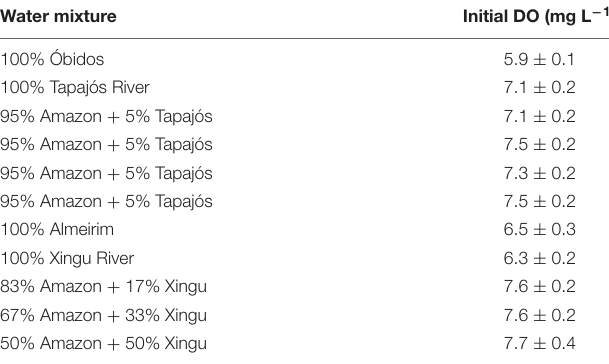
TABLE 2 | Average ( ± 1 SD) initial dissolved O 2 (DO) concentrations for each